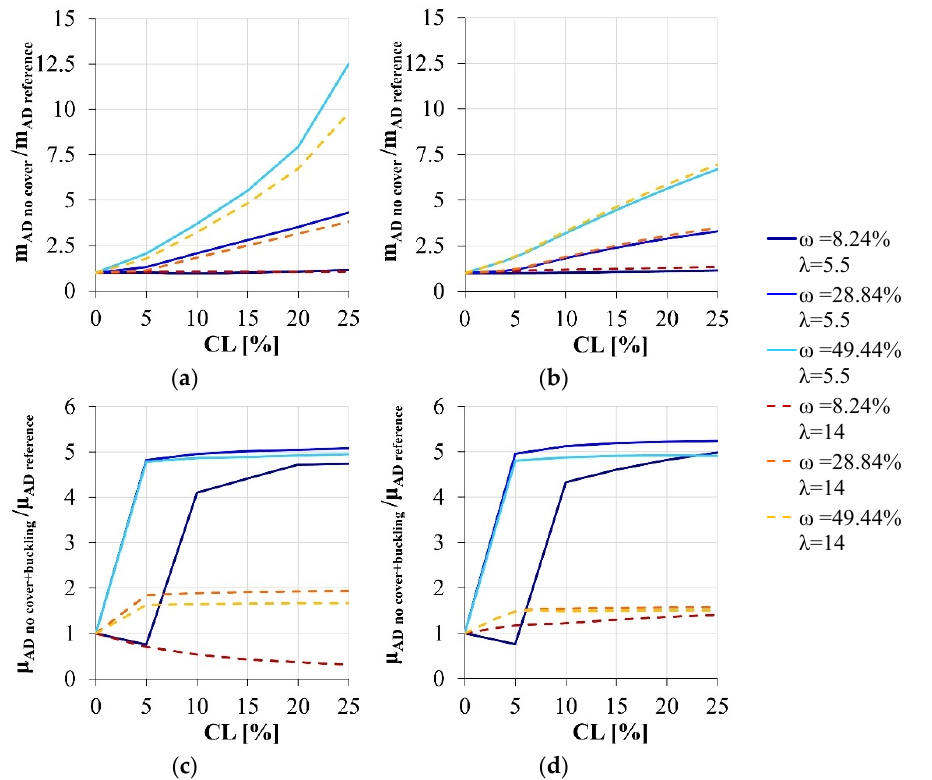
Figure 6. Load-carrying capacity variation due to the corrosion degradation: comparison between the simplified models and the reference section. ( a ) ν = 25.65%, section modeled disregarding only the concrete cover vs. reference section. ( b ) ν = 15.39%, section modeled disregarding only the concrete cover vs. reference section. ( c ) ν = 25.65%, section modeled disregarding both the concrete cover and the buckling effects vs. reference section. ( d ) ν = 15.39%, section modeled disregarding both the concrete cover and the buckling effects vs. reference section.